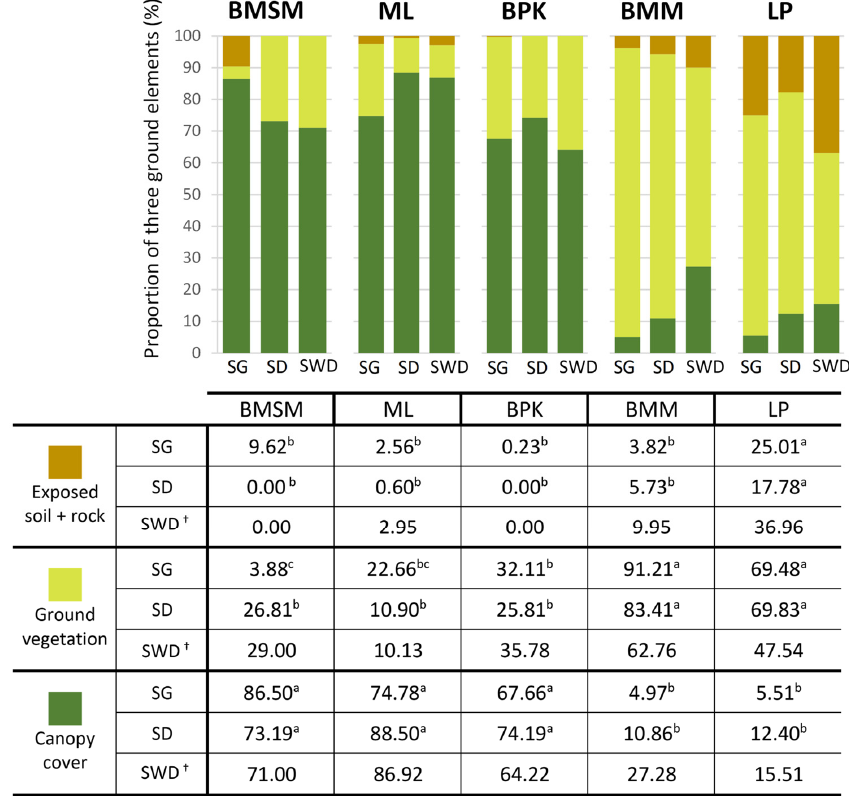
Figure 8. Percent of three ground-cover elements averaged from sample plots. (BMSM): Ban Mae Sa Mai; (ML): Mon Long; (BPK): Ban Pong Krai; (BMM): Ban Meh Me; (LP): Lampang. (SG): Sampled ground survey; (SD) Sampled drone survey; (SWD) Site-wide drone survey of each whole site. a–c within each row, comparing sites, means without a common superscript significantly differ ( p < 0.05); † Absence of significance symbols for SWD, as these are not mean values but absolute values.